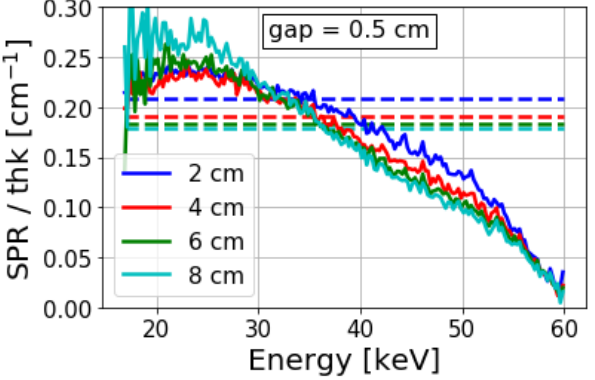
Figure 6. Simulated spectral SPR (solid) and EID SPR (dashed) for varying object thicknesses at a 0.5 cm air gap for a 60 kVp X-ray spectrum. SPR values were normalized by the object thickness to emphasize the linear dependence. EID SPR values lack energy resolution and are instead shown by horizontal lines across the full energy range for comparison with spectral